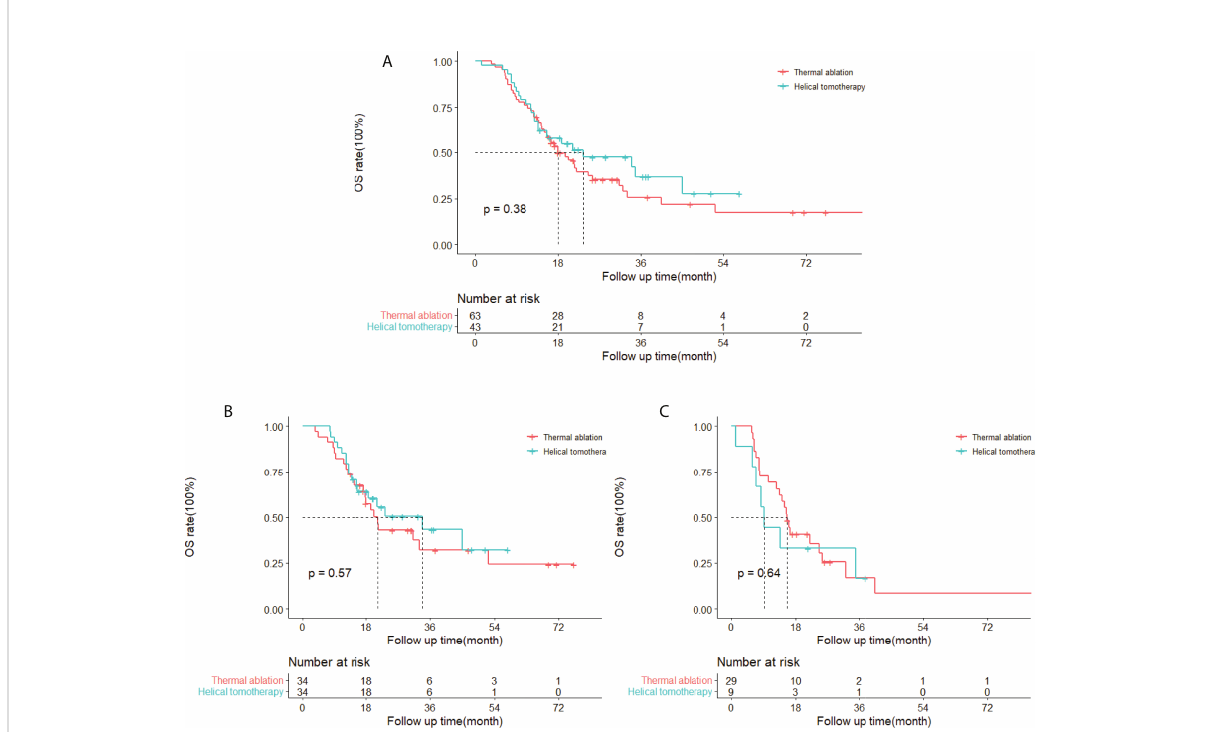
FIGURE 3 Kaplan – Meier curves of overall survival (OS) in patients with pulmonary metastases from hepatocellular carcinoma who underwent thermal ablation or helical tomotherapy. (A) Whole study population (thermal ablation group: n = 63, median OS = 18.0 months; helical tomotherapy group: n = 43, median OS = 23.4 months; P = 0.38). (B) Patients with low a -fetoprotein (AFP) level (AFP <400 ng/ml) (thermal ablation group: n = 34, median OS = 21.4 months; helical tomotherapy group: n = 34, median OS = 33.9 months; P = 0.57). (C) Patients with